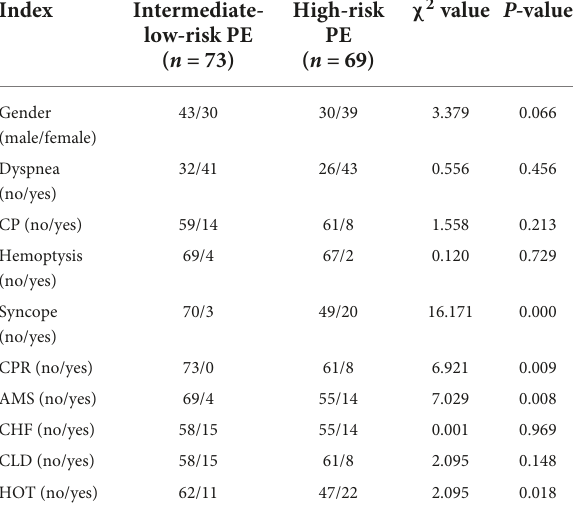
TABLE 2 Clinical characteristics in intermediate-low-risk PE patients and high-risk PE patients.